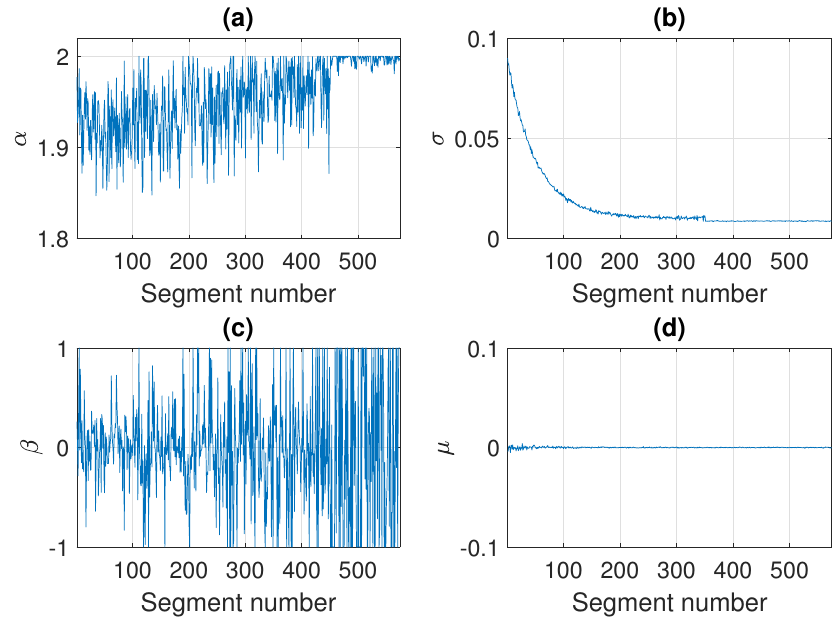
Figure 12. Estimated parameters of the stable distribution for sample simulated signal presented in panel (c) of Figure 11. Panels (a), (b), (c) and (d) correspond to α , σ , β and µ ,